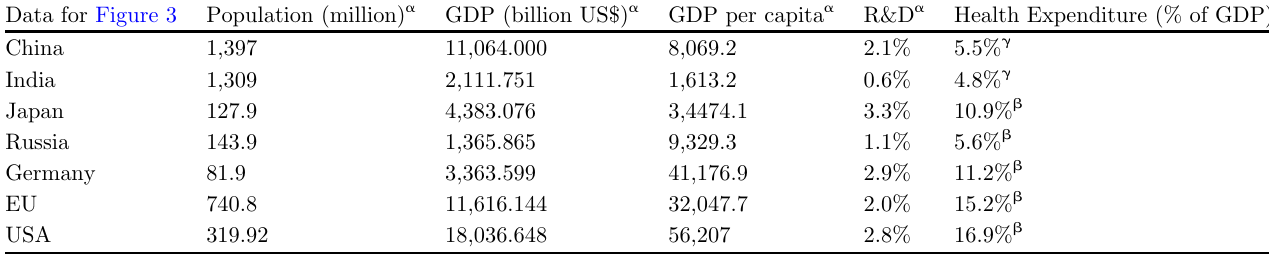
Table 1. Population (million), GDP (billion US$), GDP per capita, research and development (R&D) and Health Expenditure (% of GDP) in China, India, Japan, Russia, Germany, EU and USA, October 2017. Reference : Author ’ s calculations using [ according to [13 –